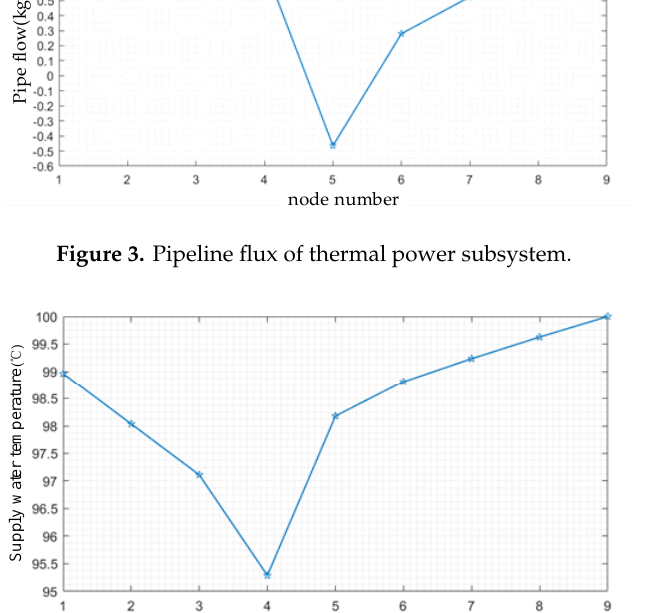
Figure 4. Node supply water temperature of thermal power subsystem.